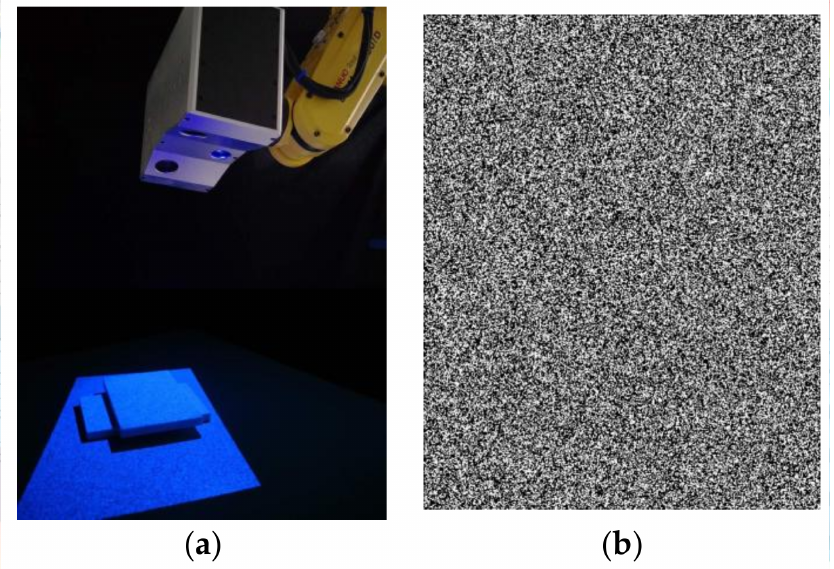
Figure 6. Experimental setup for real tests: ( a ) A single-shot stereo system with speckle projection; and ( b ) Projected speckle